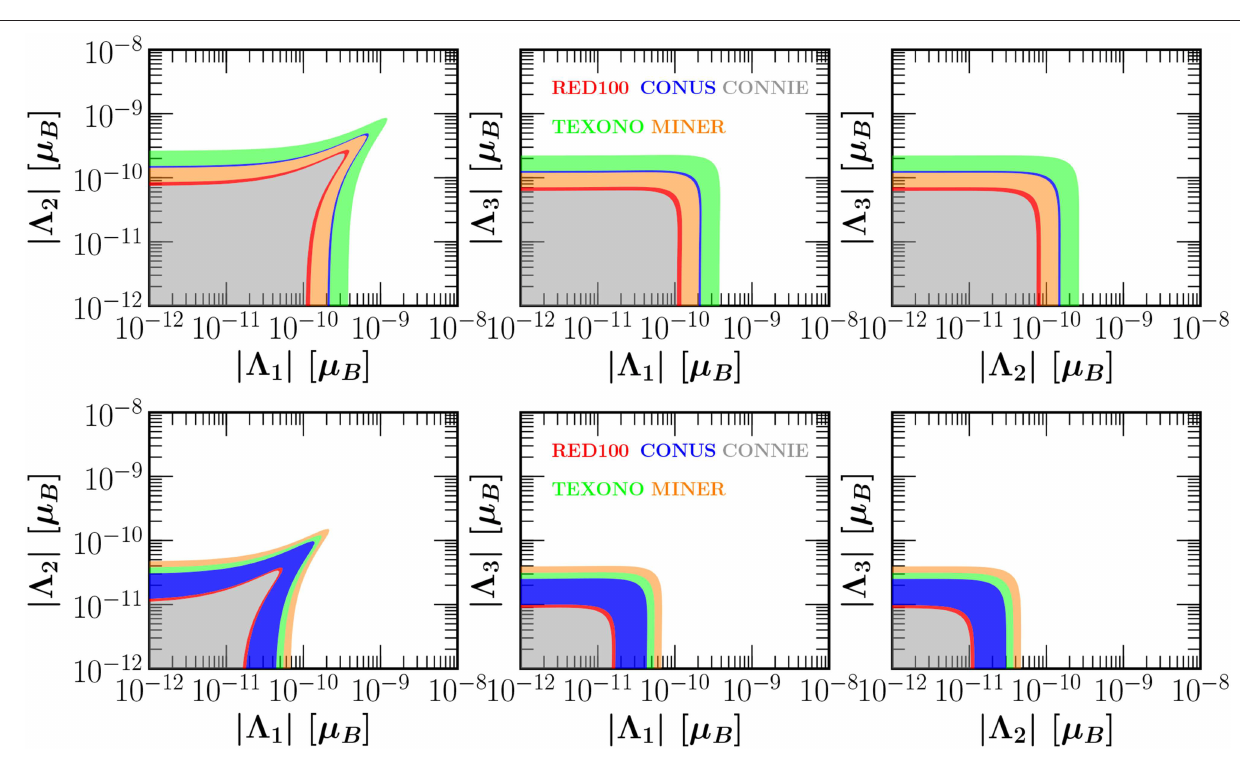
3 j 3 i parameter space that follow from the expected results of the current and future reactor based | − | 3 k and vanishing CP phases ζ i . Figure adapted from Miranda et al. [22] under the terms of the (cid:12) (cid:12) | | (cid:12) (cid:12)